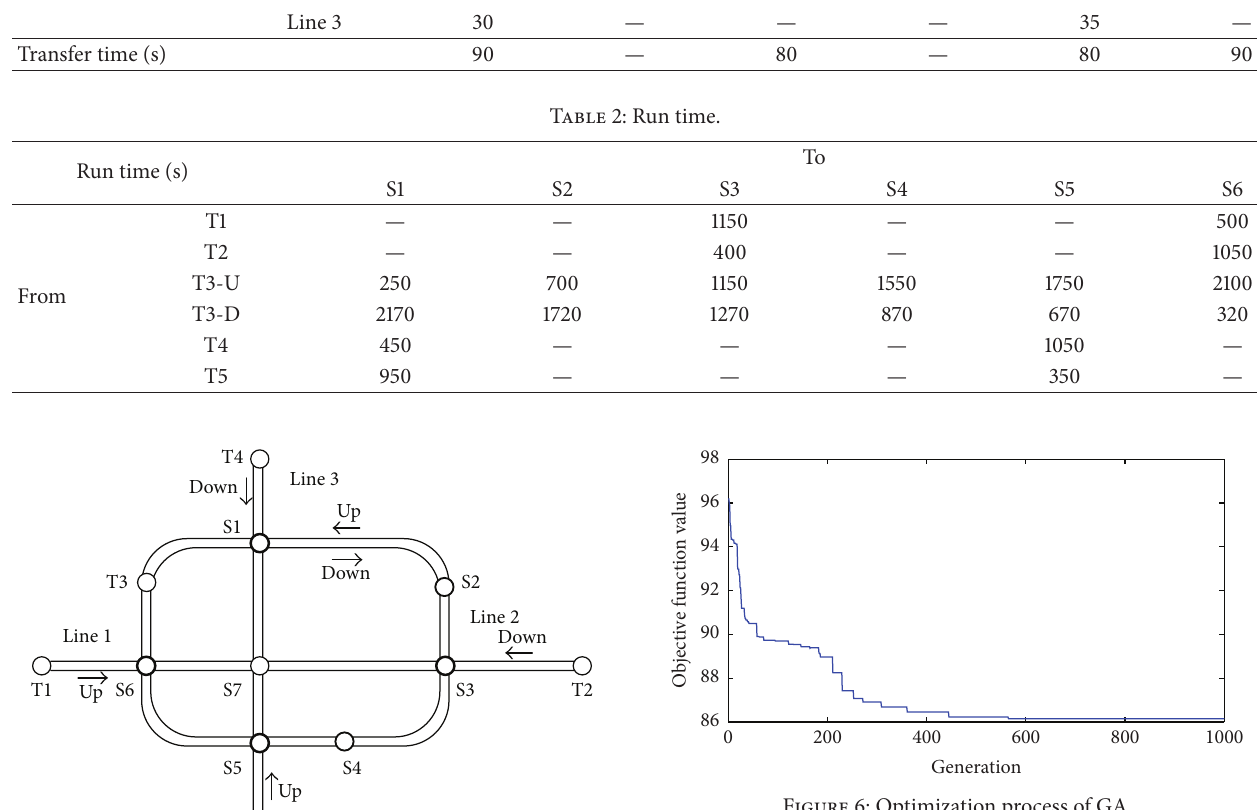
Figure 6: Optimization process of GA.